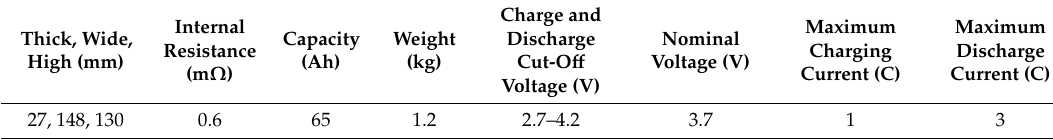
Figure 6. Battery charge and discharge experiment. ( a ) Schematic diagram of battery charge and discharge system. ( b ) Battery module. Table 1. Battery parameters.